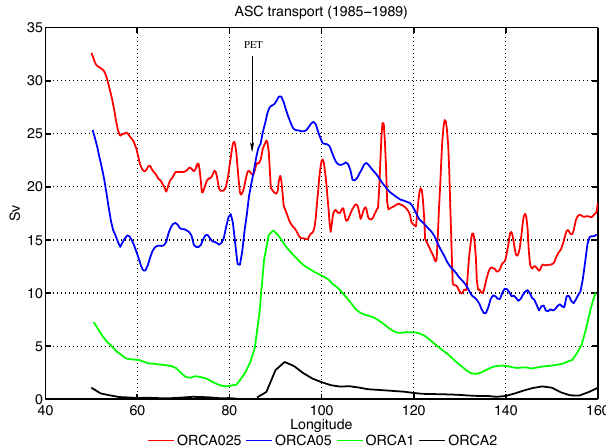
Fig. 4. Maximum cumulative westward transport from the coast to 61 ◦ S between 50 ◦ E and 160 ◦ E in February. Choice of 61 ◦ S has been done to avoid recirculation along bathymetry features like the Kerguelen Plateau. Each color (red, blue, green and black) corresponds to one resolution (ORCA025, ORCA05, ORCA1 and ORCA2). ASC flow comes in at 160 ◦ E (right side of the plot) and comes out at 50 ◦ E (left side of the plot). “PET” corresponds to the location of the Princess Elisabeth